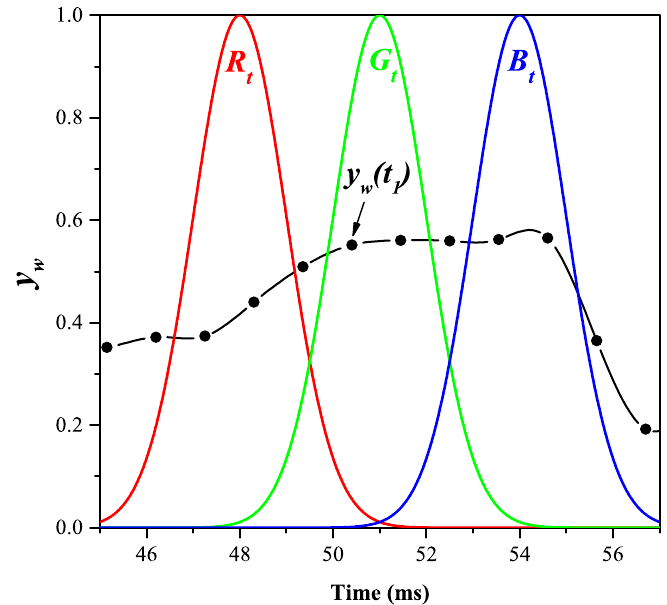
Figure 10. Example of time domain chromatic processors R t , G t , B t superimposed upon the time